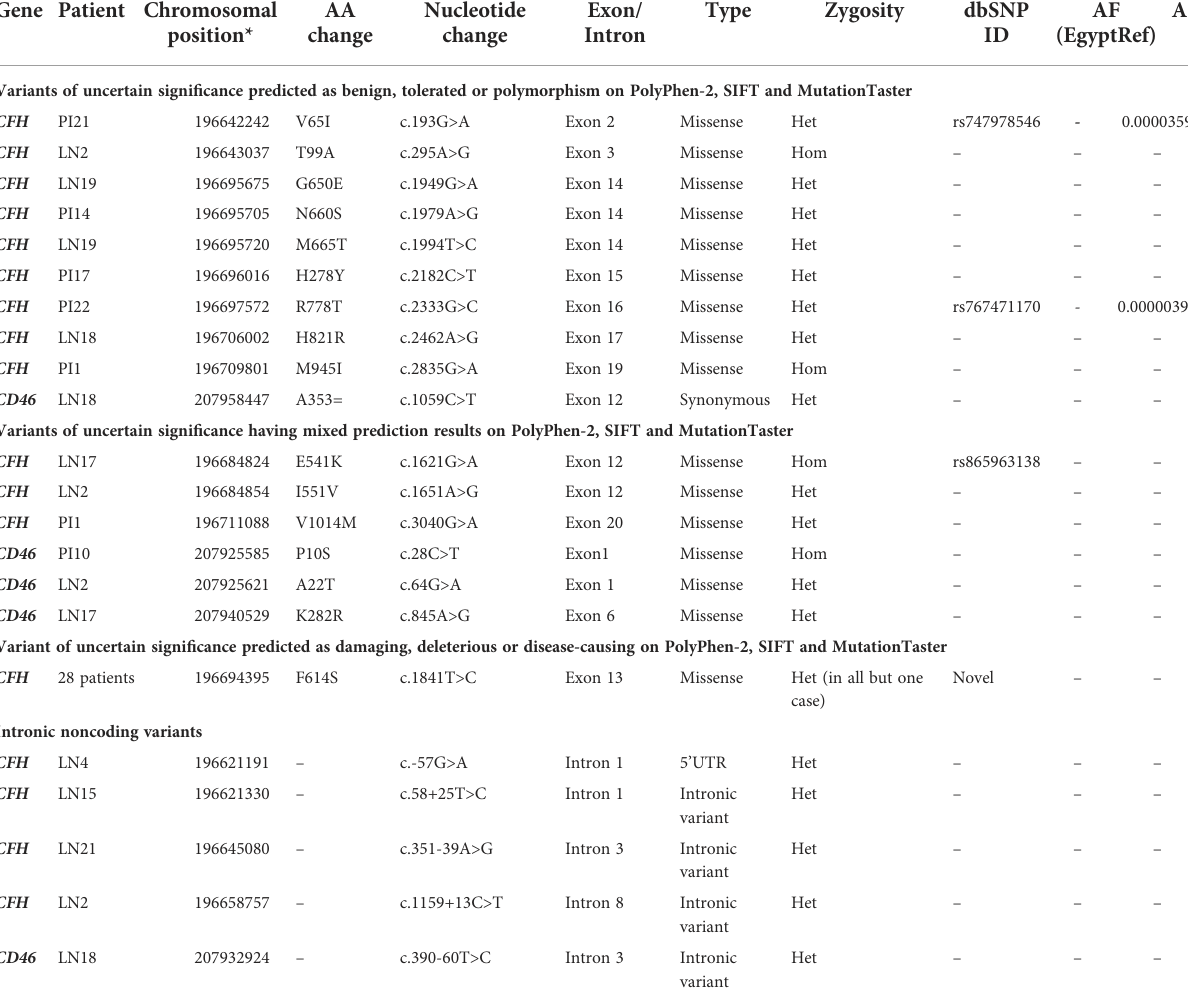
TABLE 4 Variants of uncertain signi fi cance are classi fi ed according to the in-silico prediction tools.